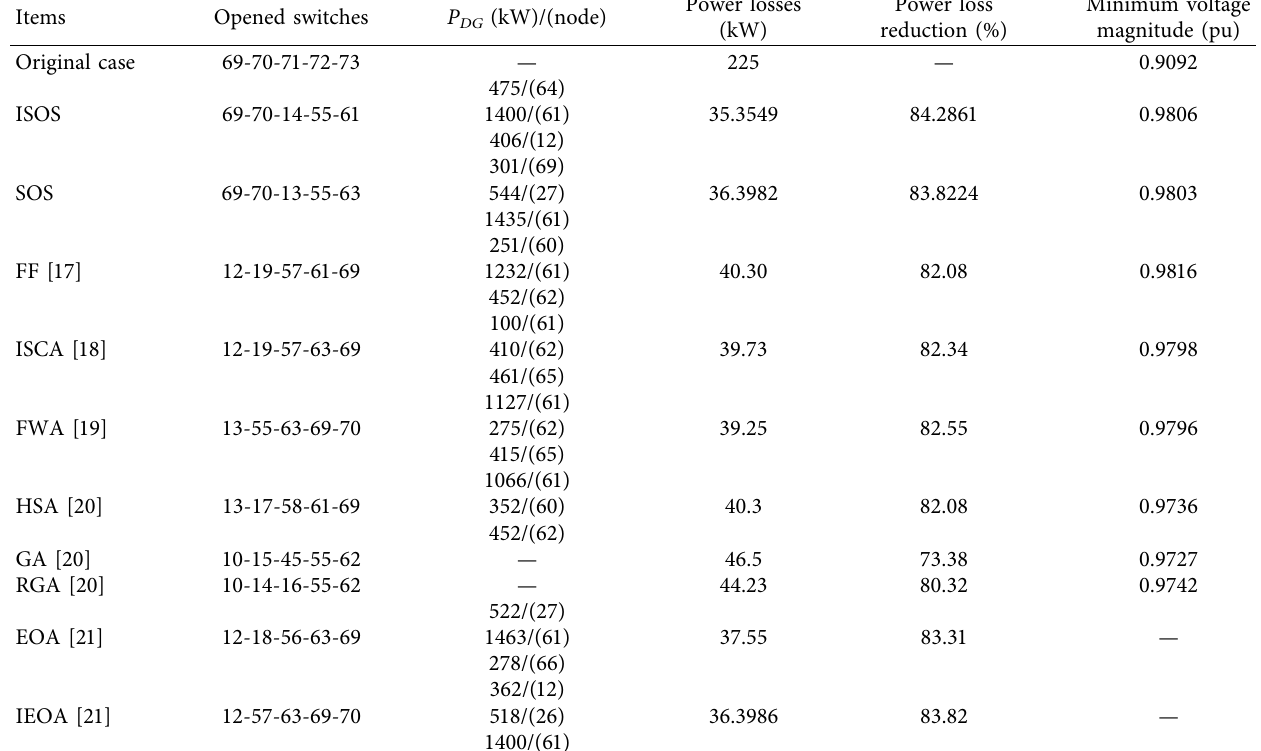
4.2. 69-Bus System. ISOS method was employed in the 69- node system with 73 branches and 69 nodes, as shown in Figure 5. Te line and load data for the 69-node system can be found in Supplementary Table S2. For the original case, minimum voltage amplitude and power losses were 0.9092 pu and 225.03 kW [29], respectively. Te results attained by ISOS for the 69-bus system are given in Table 2.